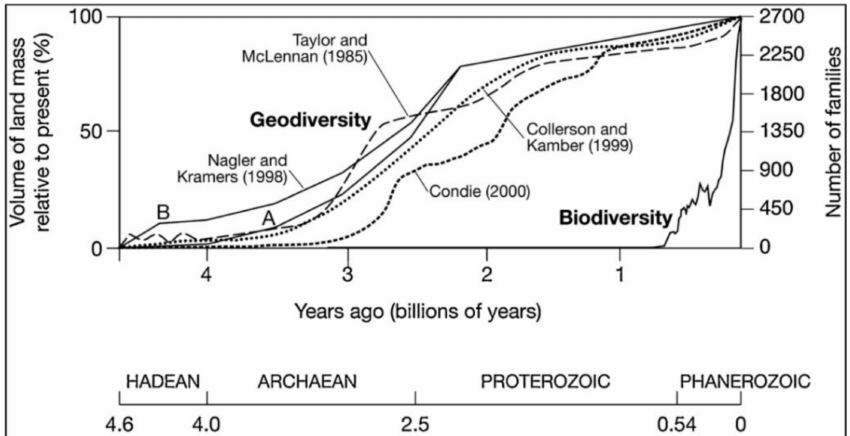
Figure 2. Curves showing the enrichment of biodiversity and geodiversity through time. Note the discrepancy in the temporal scale: while biodiversity has seen a steep rise since about 500 million years ago, geodiversity is more ancient, and its major enrichment phase dates to nearly 3 billion years ago with the evolution of the continental crust. Reproduced from [37], with permission from Elsevier,